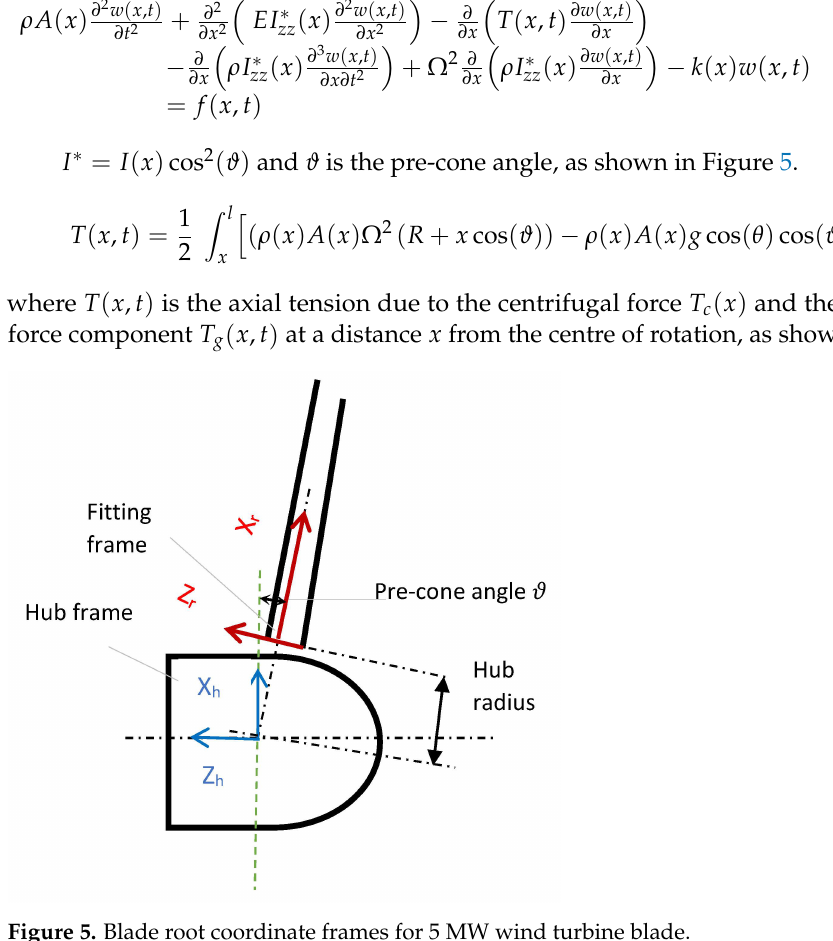
Figure 5. Blade root coordinate frames for 5 MW wind turbine